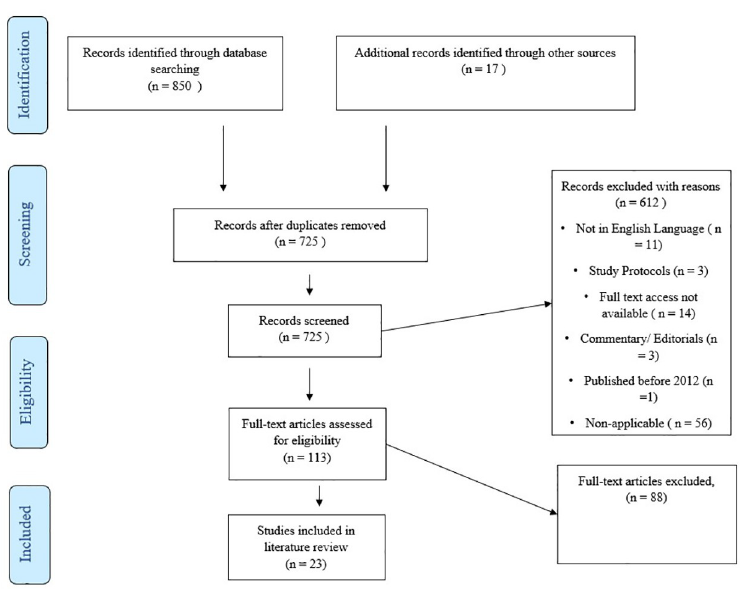
Fig 1. PRISMA ScR